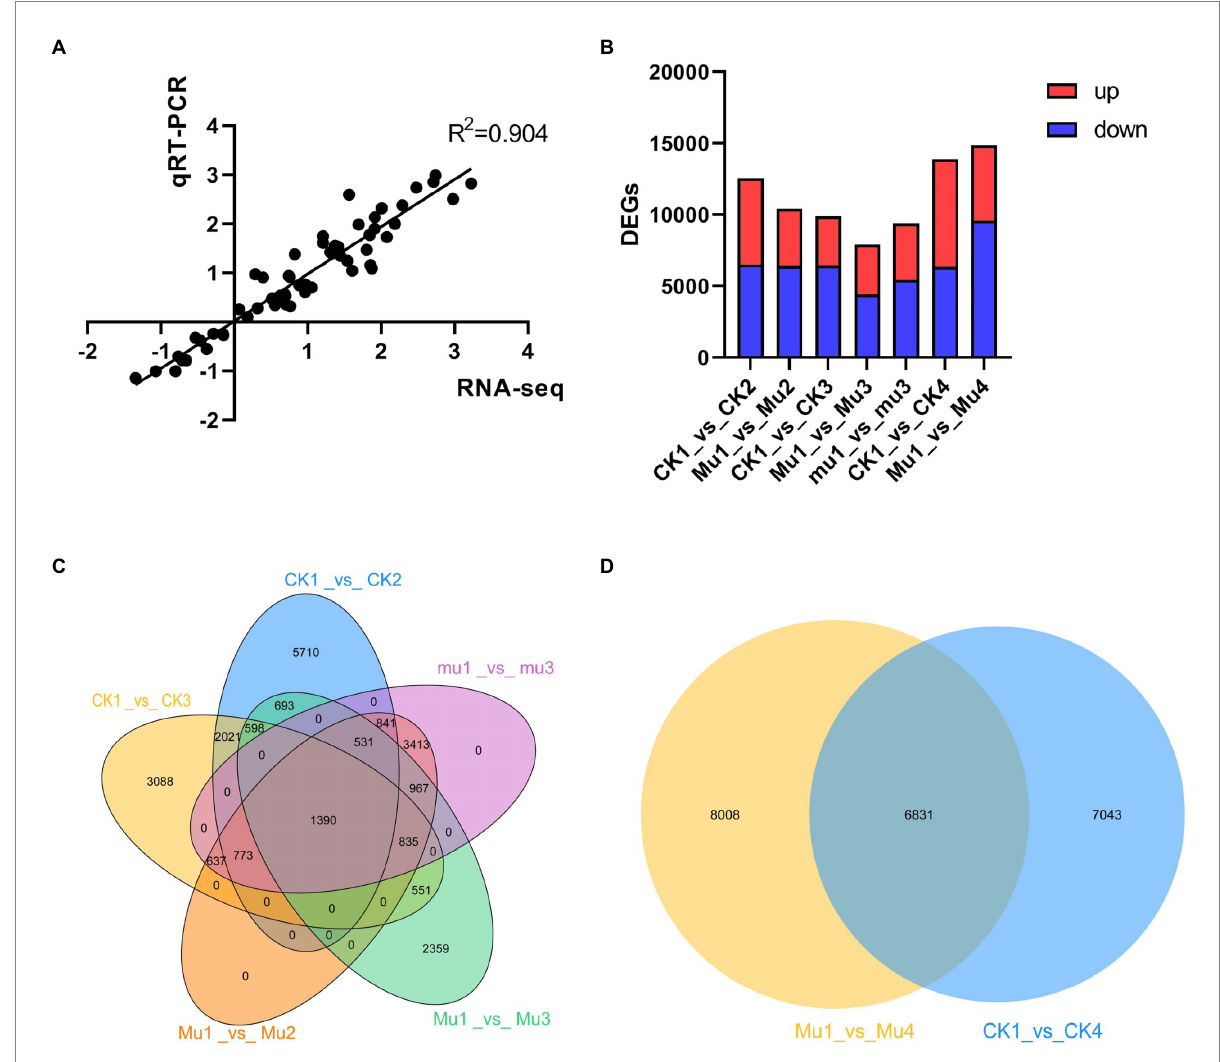
FIGURE 3 Overall transcriptomic analysis of wheat during drought stresses and recovery. (A) Correlation analysis of qRT-PCR and RNA seq results. (B) Statistics of DEGs during moderate and severe drought stresses and rehydration. (C) Venn diagram of DEGs during moderate and severe drought stresses. (D) Venn diagram of DEGs after